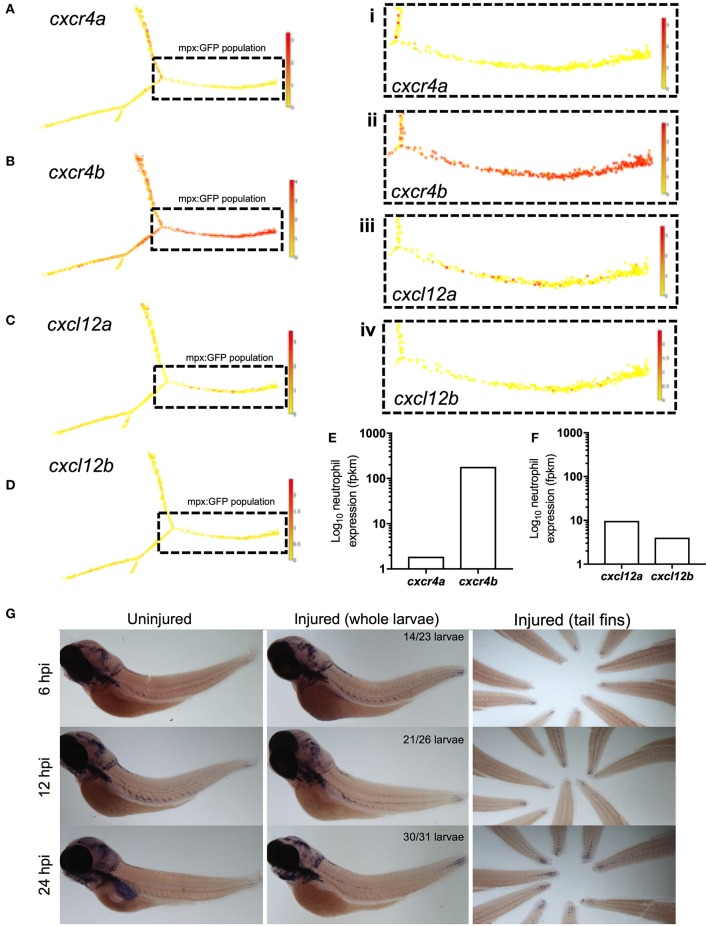
cxcr4b and cxcl12a are expressed following tissue damage in zebrafish. (A–D) Single-cell gene expression profiles for cxcr4 and cxcl12 in the zebrafish blood lineage. Single cell gene expression values extracted from the Sanger BASiCz zebrafish blood atlas. Circles represent individual cells color coded where red is high expression and yellow is no expression. Neutrophil lineage (mpx:GFP positive) is highlighted by black dashed box and expanded in (i–iv). (E,F) RNA sequencing of FACS sorted GFP positive cells from TgBAC(mpx:GFP)i114 zebrafish larvae at 5 days post fertilization. FPKM values illustrate neutrophil expression of (E)
cxcr4a and cxcr4b and (F)
cxcl12a and cxcl12b. (G) Whole mount in situ hybridization using an antisense DIG labeled RNA probe for cxcl12a mRNA. Wildtype nacre zebrafish larvae were injured and fixed in PFA at 6, 12, and 24 h post injury, along with uninjured age-matched control larvae. Left and middle panels show whole zebrafish larvae at timepoints indicated, right panel shows tail fins of a representative experiment. Quantification shows number of larvae which look like representative image from 2 independent experiments.